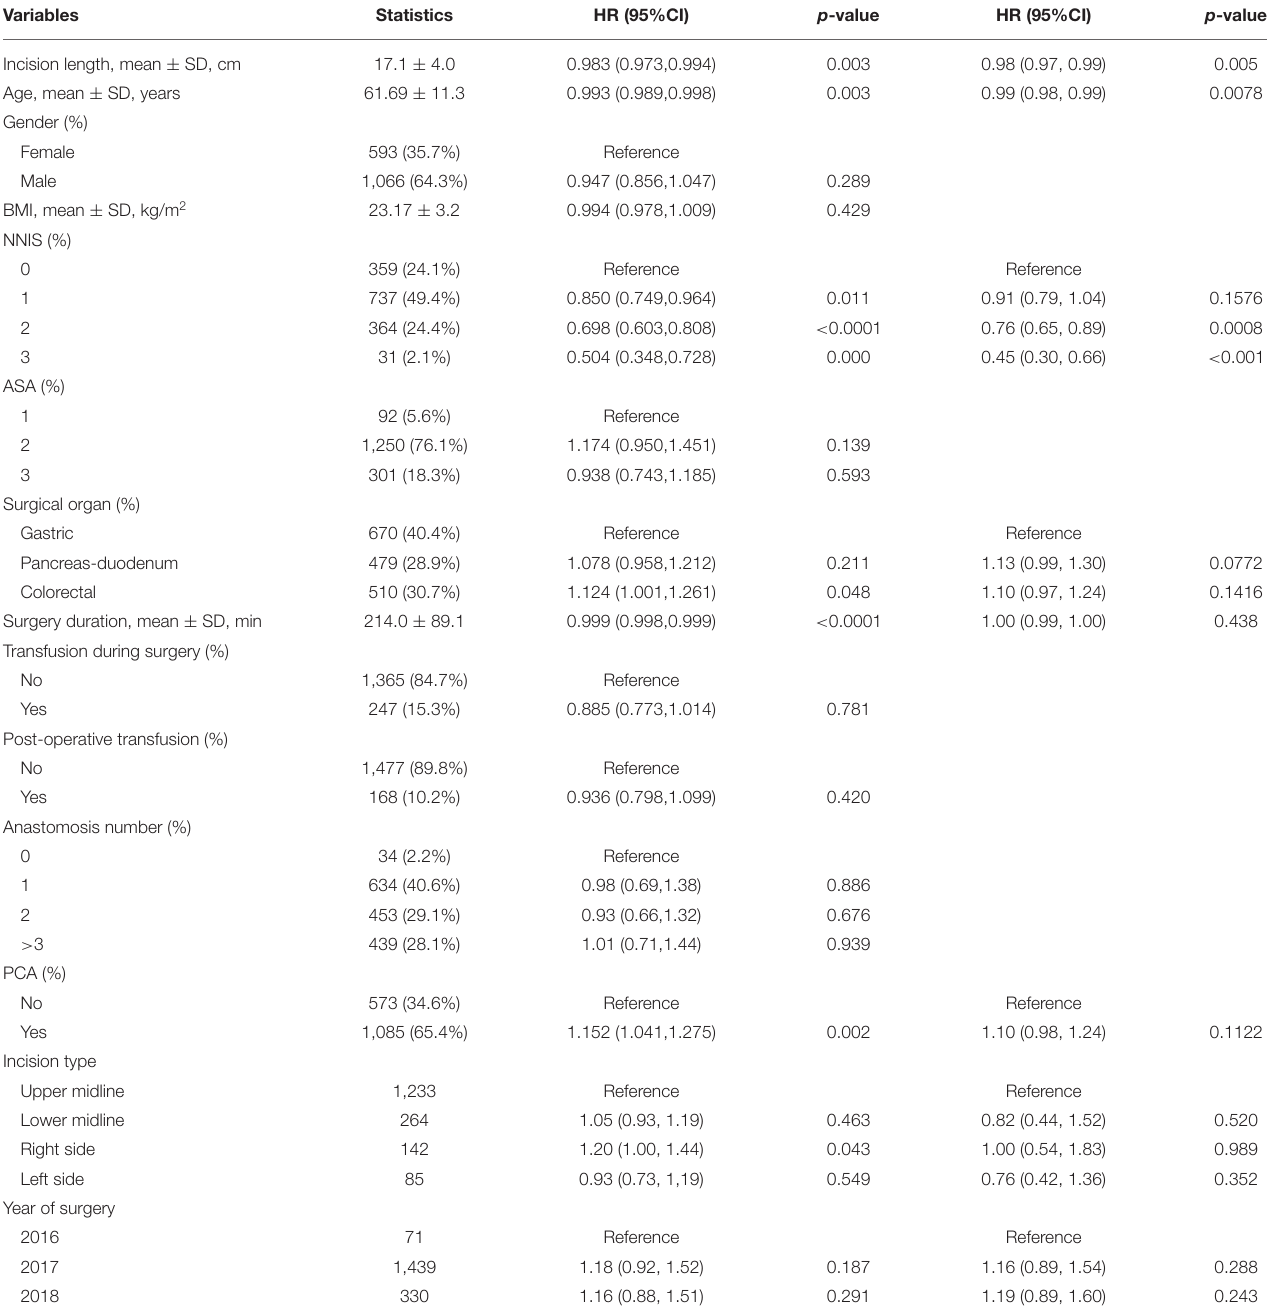
TABLE 4 | Univariate and multivariate Cox analysis for the days to the first bowel movement.